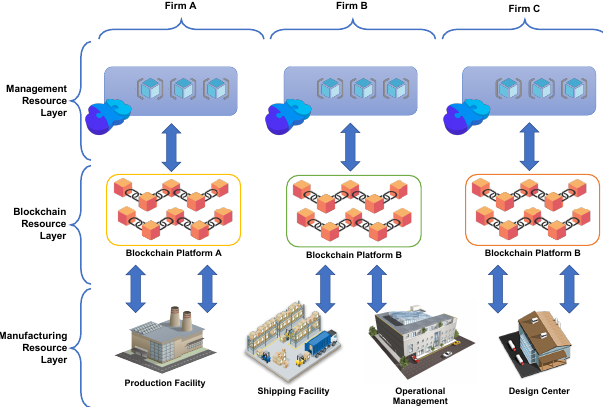
Figure 1. Blockchain integration within a generic industry process for collaborative